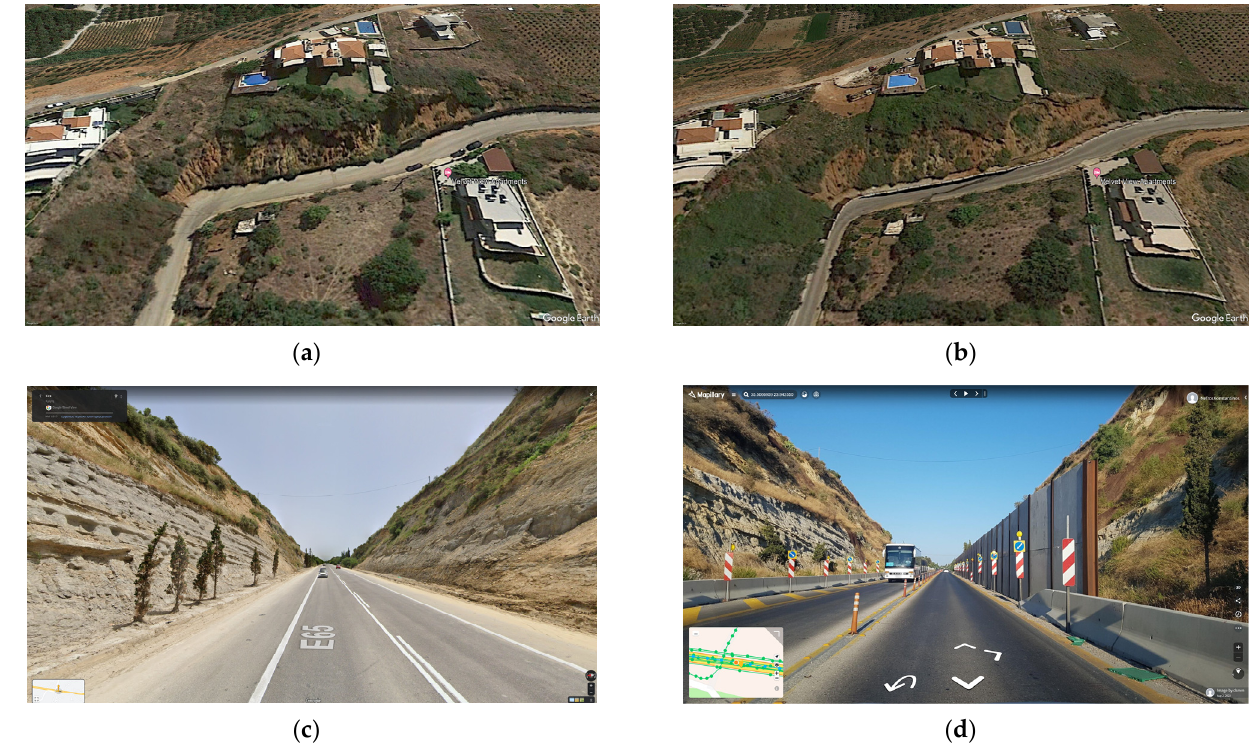
Figure 7. Monitoring of potential ongoing landslide events using open access data of: ( a ) Google Earth Satellite view at Stalos village Jun 2013 [39]; ( b ) Google Earth Satellite view at Stalos village March 2022 [40]; ( c ) Google Street view at motorway A90 outside Stalos village May 2019 [41]; ( d ) Mapillary Street view at motorway A90 outside Stalos village [42].